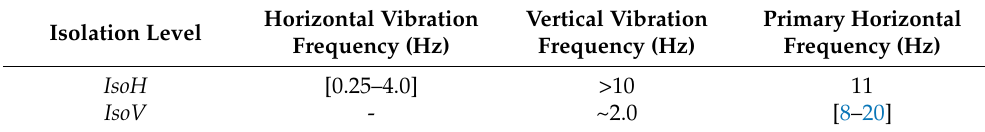
Table 2. Frequency-dependent properties of both isolation levels.